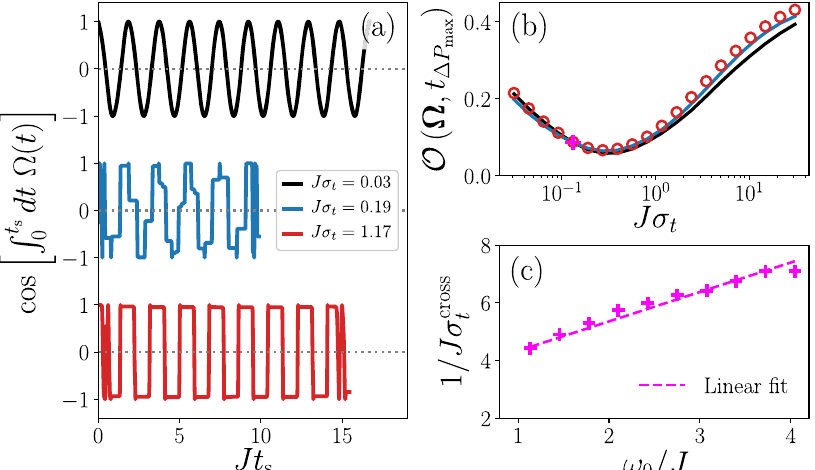
Fig. 3 Optimizing for detection for correlated background noise (Lorentzian spectrum) in the SCA. a Different SCA-optimal control ffiffiffiffiffiffiffiffiffiffi p π = 30 schemes from the SGD-based optimizer for increasing correlation times J σ t = 0.03, 0.19, and 1.17. The signal is at ω 0 = J ¼ 10 . b Comparison of the maximum of the objective function O [see Eq. (5)] as a function of background noise correlation, σ t , in comparison to SL . The signal is the same as in a . The SCA-optimal control and CPMG sequences with their corresponding detection times set to t s ¼ t Δ P max (pink plus). It is close to SL (solid black line) when σ t < σ cross , and crossing over to CPMG (shown as red circles) exhibits a crossover at σ t ¼ σ cross t t (solid blue line) when σ t > σ cross . c The inverse of the crossover correlation time, 1 = σ cross as a function of the center of the signal frequency ω 0 t t keeping the SNR α fi xed. The dashed line is a linear fi t to the